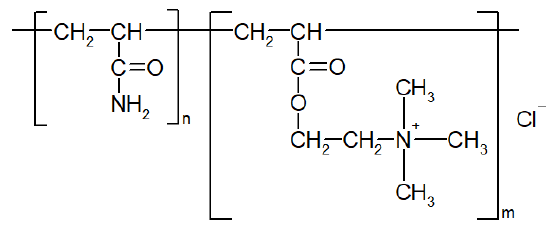
Figure 1. Chemical formula of cationic polyelectrolyte Praestol 859.